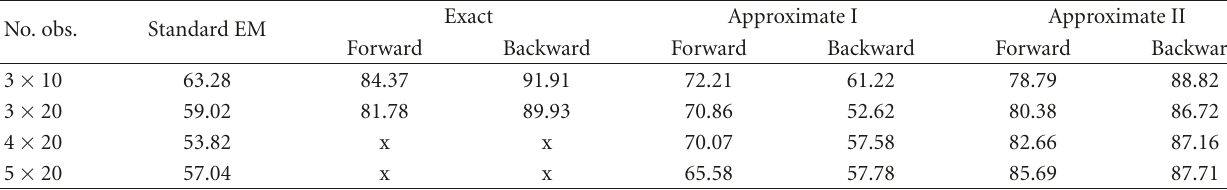
Table 5: Mean of data association accuracy of di ff erent inference algorithms in EM framework (%). No.